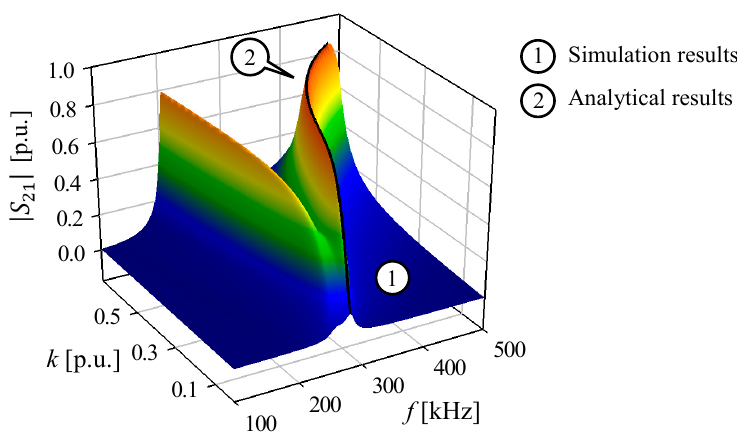
Figure 6. The magnitude of the scattering parameter S 21 (1) and the trajectory of its maximum val- ues (2) expressed in terms of the operating frequency ( f ) and coupling coefficient ( k ).